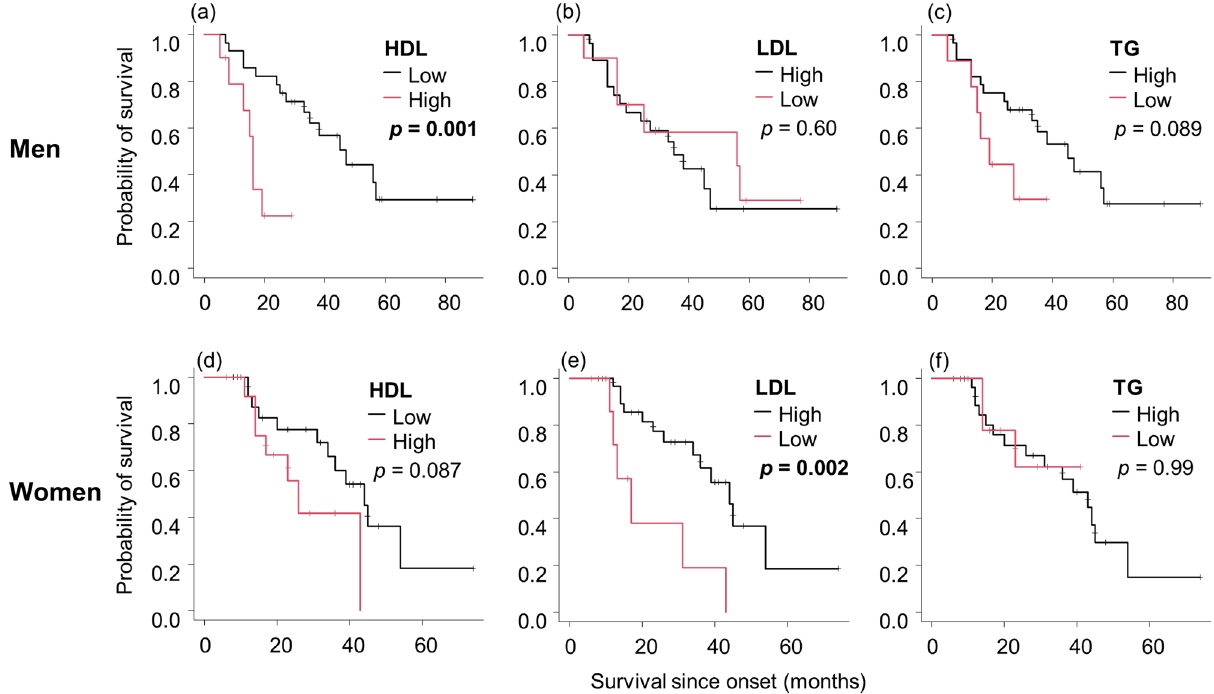
Figure 1. The relationship between the lipid profiles and survival in each sex. Kaplan–Meier analyses and log- rank tests revealed that men with high HDL ( a ) and women with low LDL ( e ) had significantly shorter survival. Men with low TG ( c ) and women with high HDL ( d ) showed the same trend, although not significant. There was no significant relationship in the other groups ( b , f ). Abbreviations: HDL, high-density lipoprotein; LDL, low-density lipoprotein; TG, triglycerides.